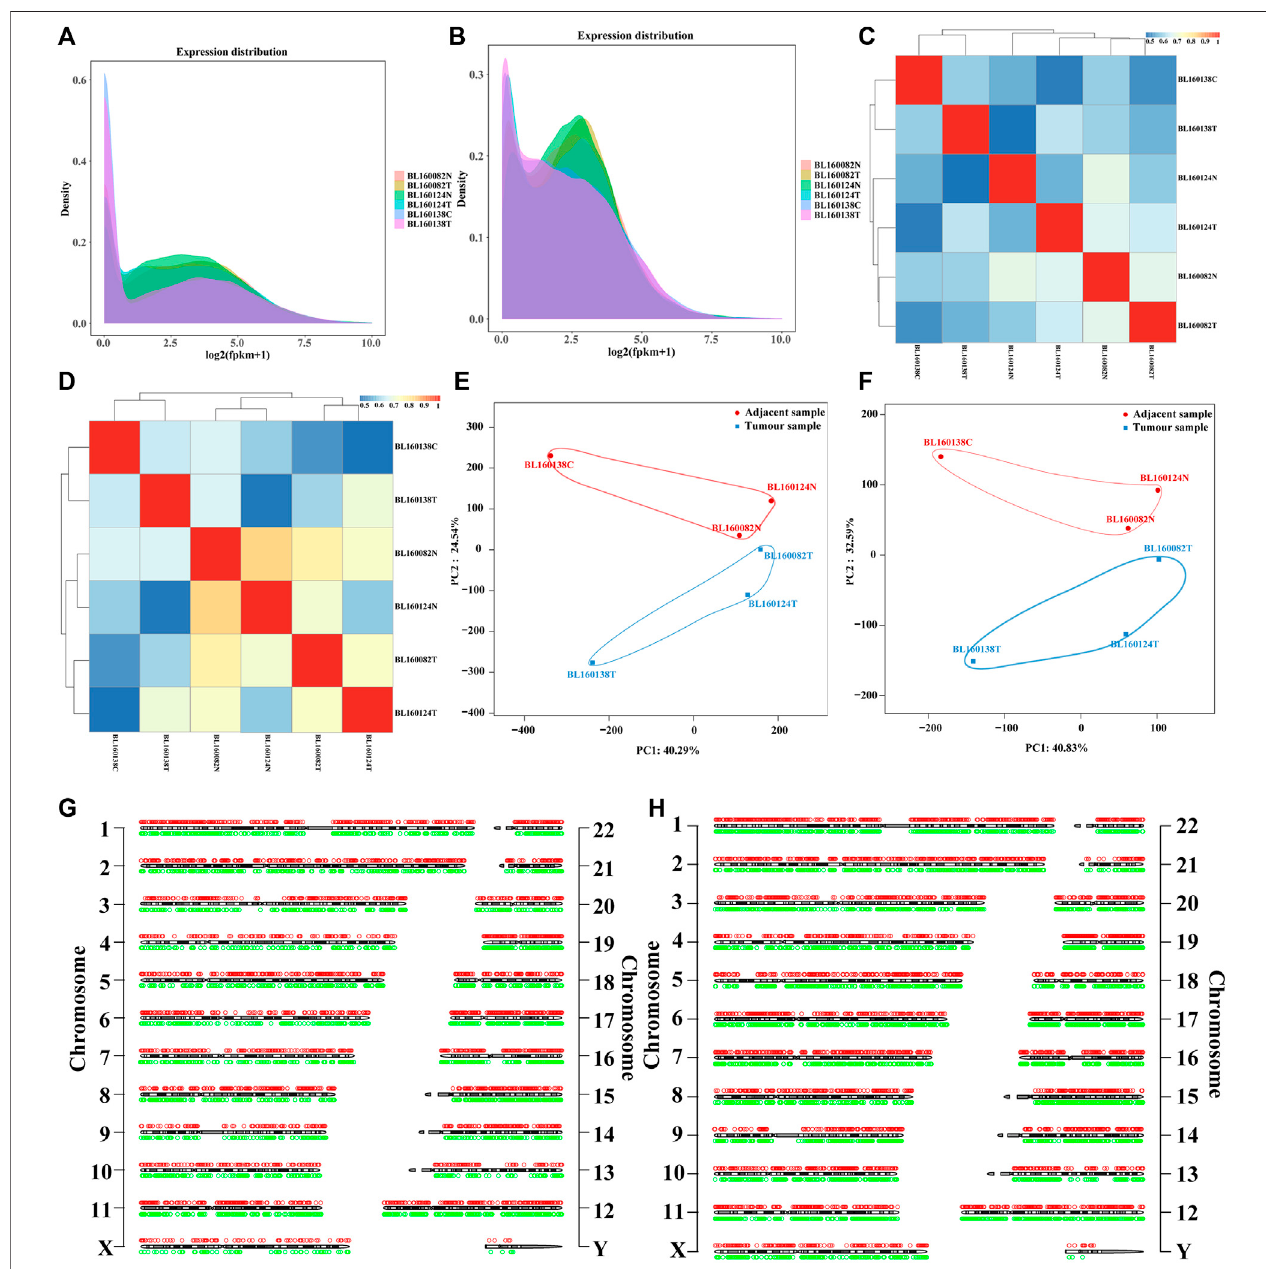
FIGURE 1 | (A) lncRNAs expression density distribution in each sequencing sample. The peak region represents the region where the gene expression level is concentrated in the sample, which is used to compare thedifferences ofgene expression patterns among different samples. (B) mRNAs expression density distribution in each sequencing sample. The peak region represents the region where the gene expression level is concentrated in the sample, which is used to compare the differences of gene expression patterns among different samples. (C) Correlation heat map between sequencing samples based on lncRNAs expression. (D) Correlation heat map between sequencing samples based on mRNAs expression. (E) Principal component analysis between sequencing samples based on lncRNAs expression. The blue markers were bladder cancer tissue samples, and the red markers were the corresponding adjacent tissues samples. (F) Principal component analysis between sequencing samples based on mRNAs expression. (G) The distribution of annotated lncRNAs in sequencing data on chromosomes (hg38 as reference). (H) The distribution of annotated mRNAs in sequencing data on chromosomes (hg38 as reference). The red circles represent up-regulated RNAs (lncRNAs and mRNAs), the green circles represent down-regulated RNAs (lncRNAs and mRNAs), and the black and white cylinder in the center represent chromosomes. The numbers on both sides were the chromosome numbers. X and Y represent chromosomes. BL160082T, BL160124T and BL160138T were bladder cancer tissue samples, while BL160082N, BL160124N and BL160138C were corresponding adjacent tissues samples.